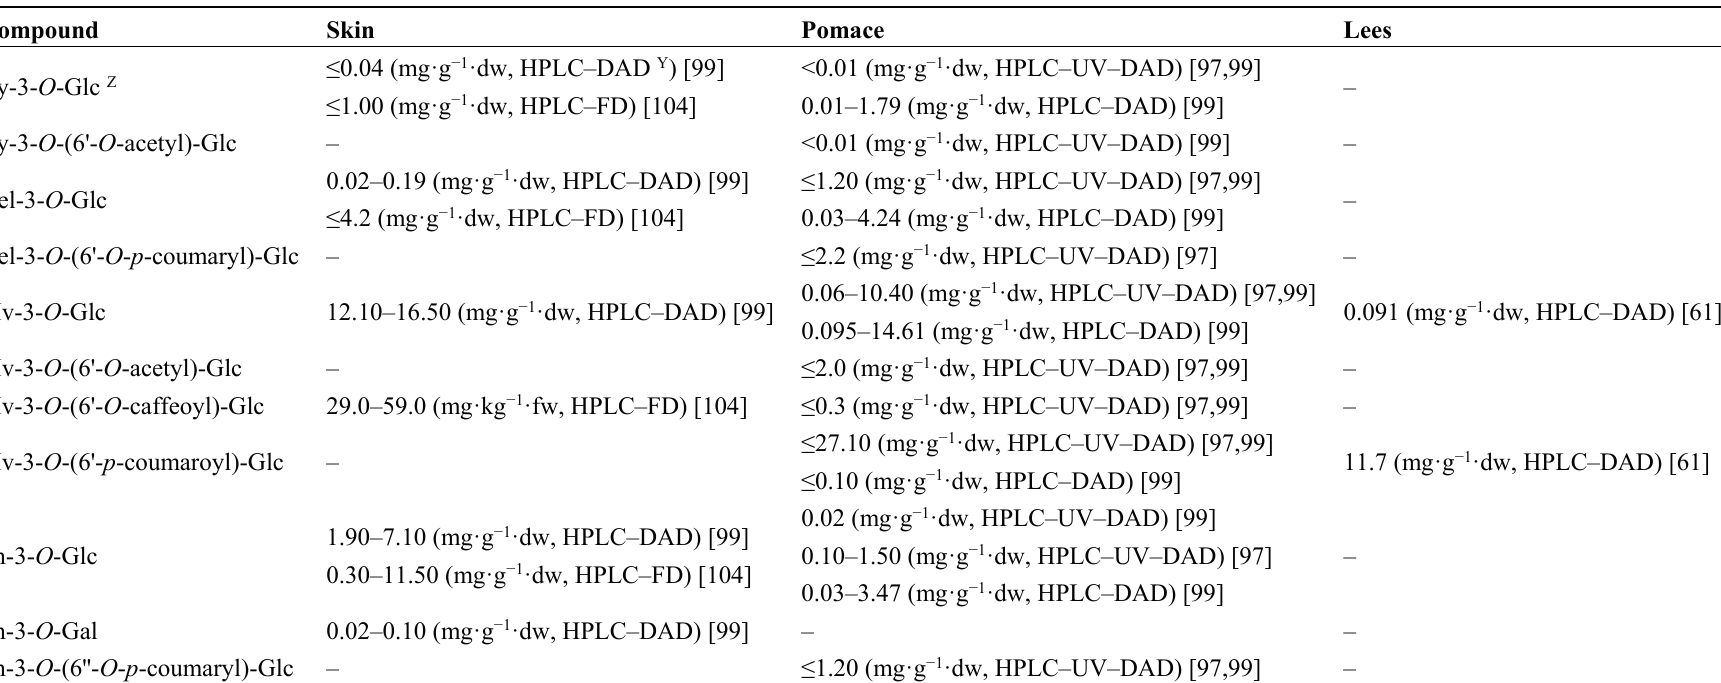
Table 5. Content in anthocyanins of winery residues from different red varieties of Vitis vinifera L.